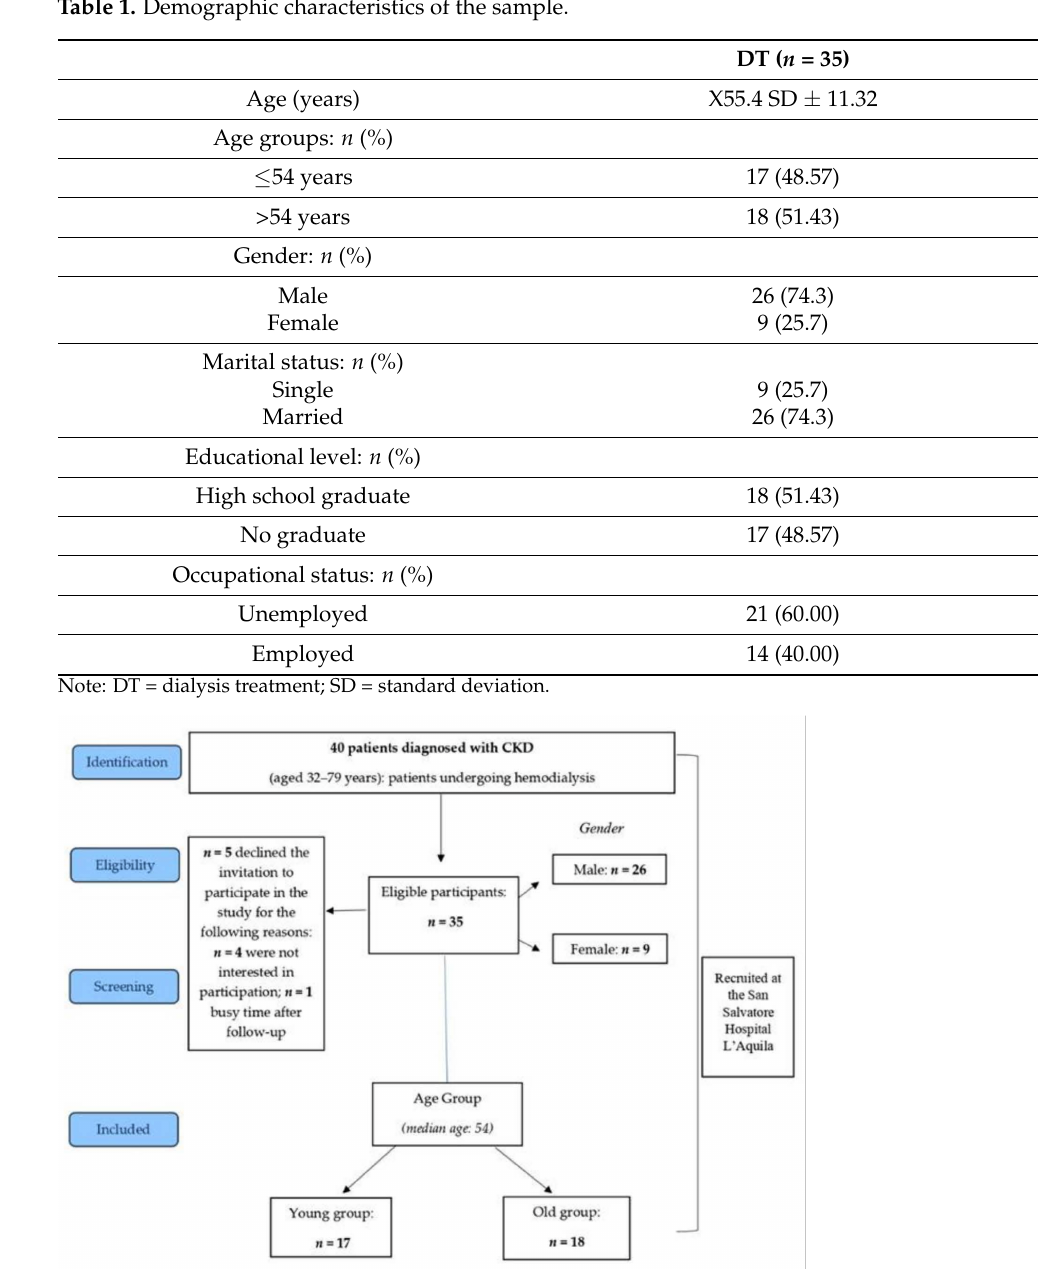
Figure 1. Flowchart of